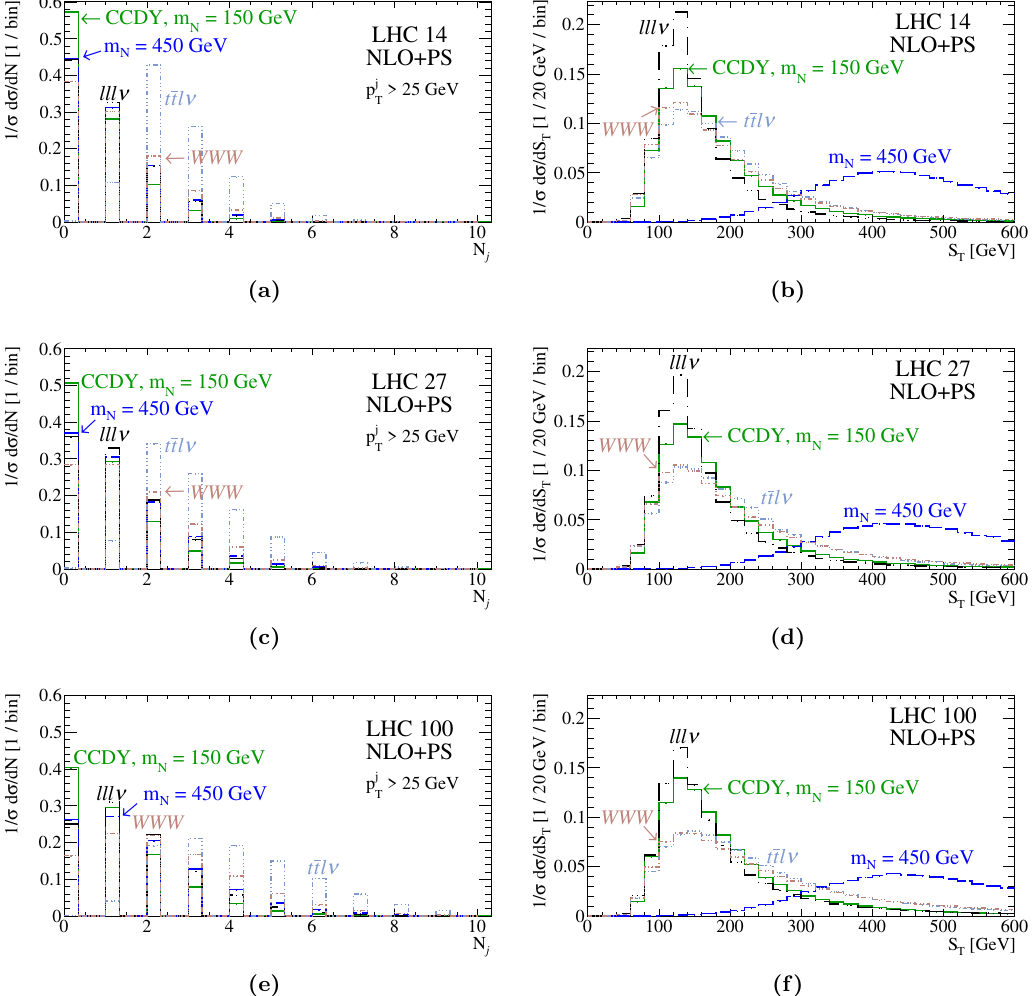
Figure 17. Same as (cid:12)gure 16 but for (a,c,e) the number of jets with p j